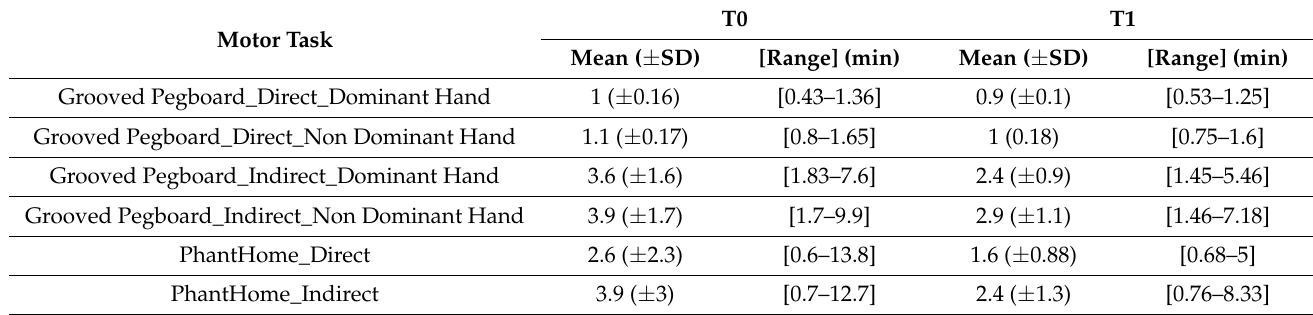
Table 1. The mean, standard deviation (SD), and range of the Grooved Pegboard test and PhantHome test scores under direct and indirect vision conditions at the two time periods (T0, T1) for dental students (N = 42). Motor Task